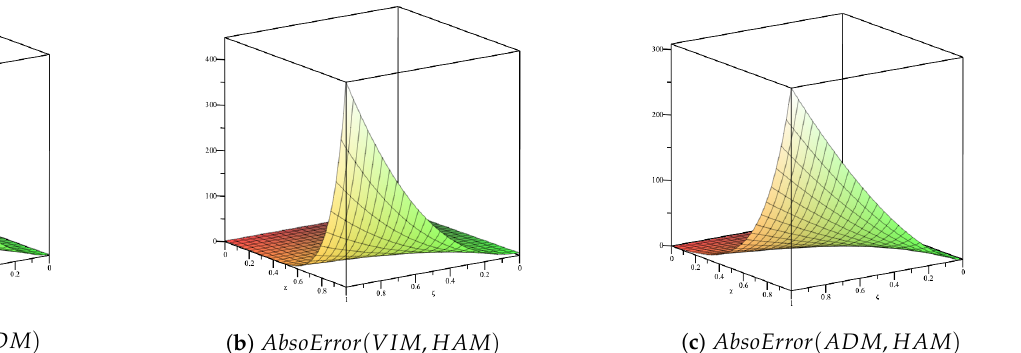
Figure 2. Graphical simulation of the absolute error when η = 0.75 and ¯ h = − 1 for Example